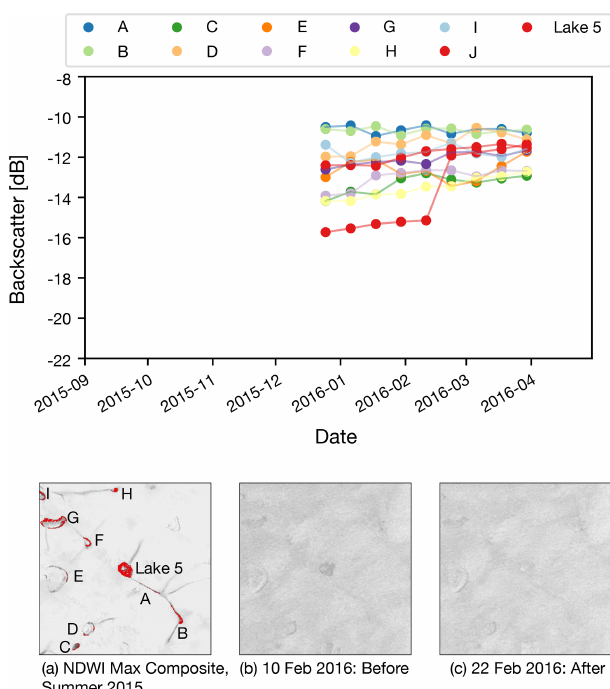
Figure D5. Lake 5 surrounding